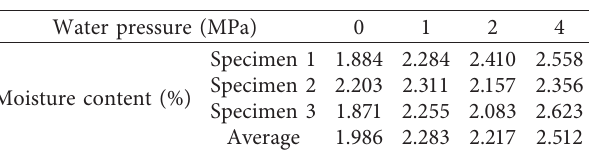
Table 7: Moisture content of concrete under different water